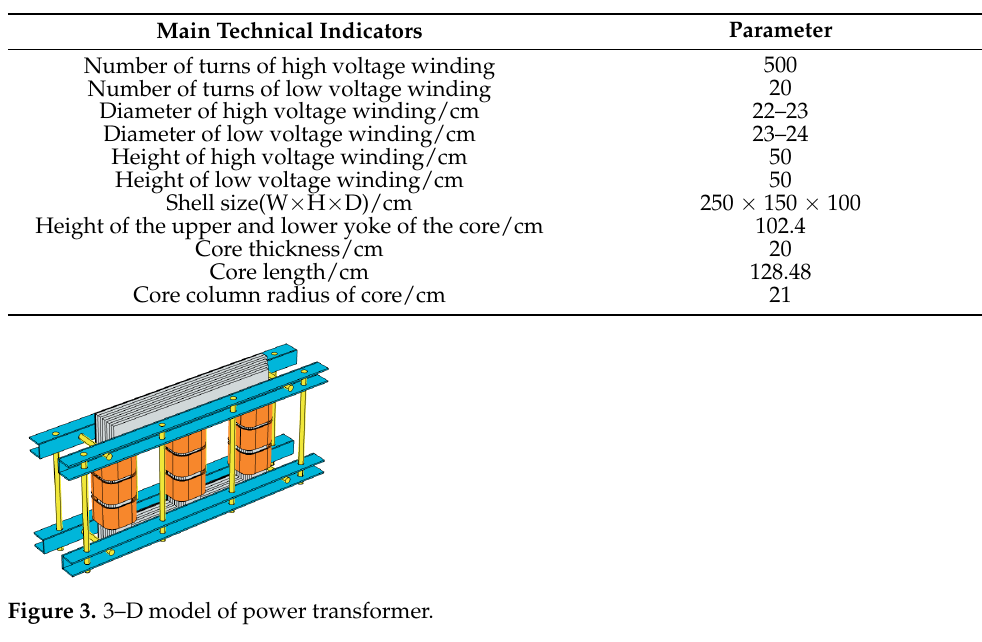
Table 2. Parameters of transformer winding and core.